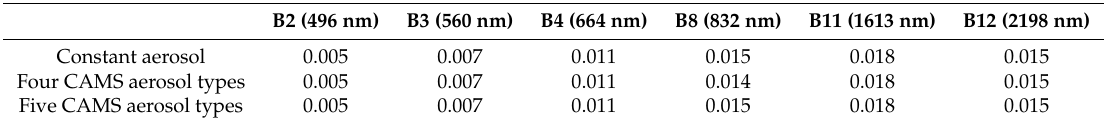
Table 10. Noise criterion of the MACCS-ATCOR Joint Algorithm (MAJA) surface reflectance time series, for arid sites. CAMS: Copernicus Atmosphere Monitoring Service.